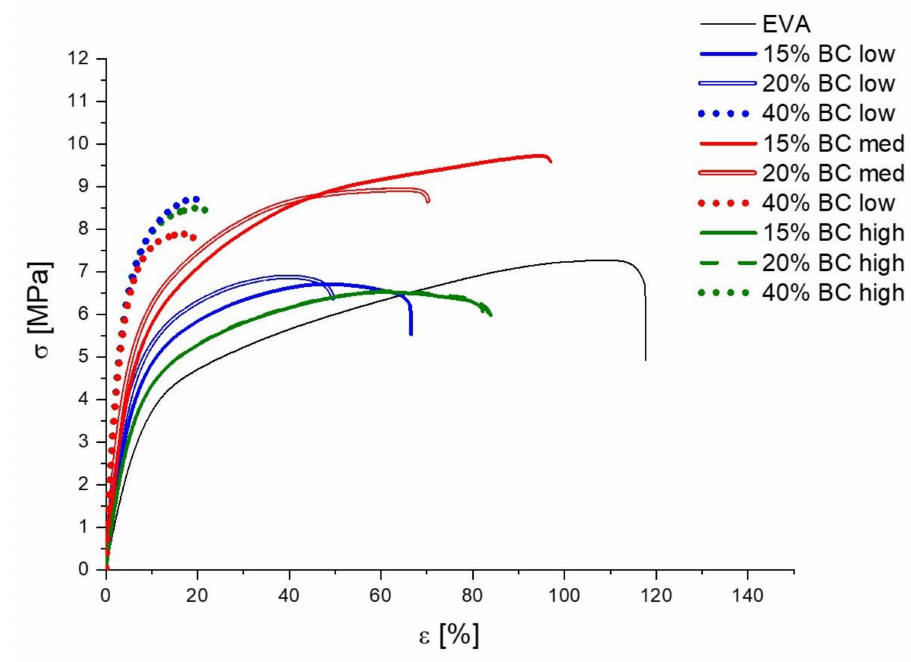
Figure 7. Stress–strain curves for EVA and EVA/BC compounds. Table 5. Tensile properties of EVA and EVA/BC